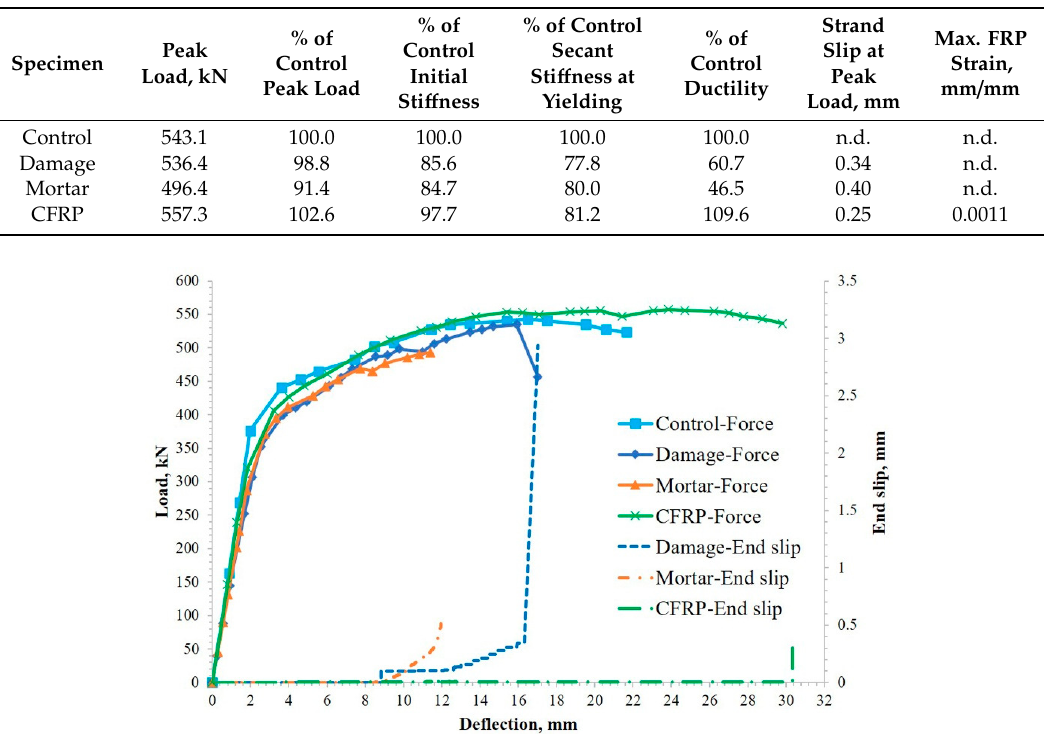
Figure 7. Load, end slip vs. deflection curves.